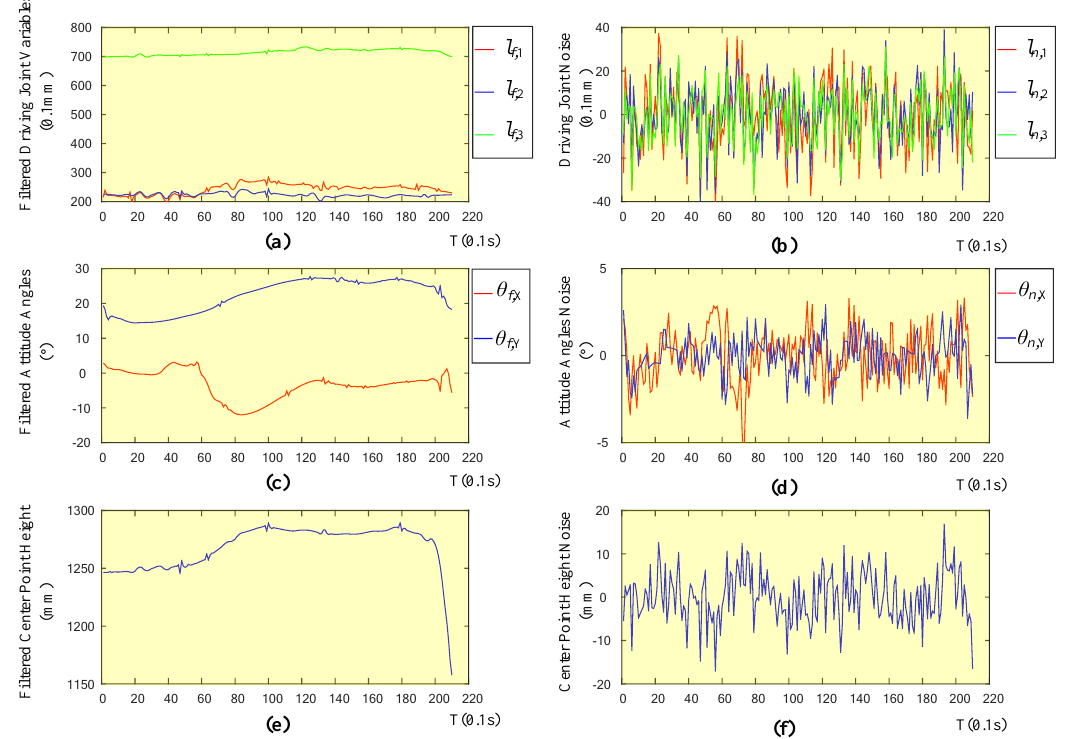
Figure 16. ( a ) The filtered curve of driving joint variables, ( c ) attitude angles, ( e ) center point height, and ( b ) noise curve of driving joint variables, ( d ) attitude angles, ( f ) center point height.